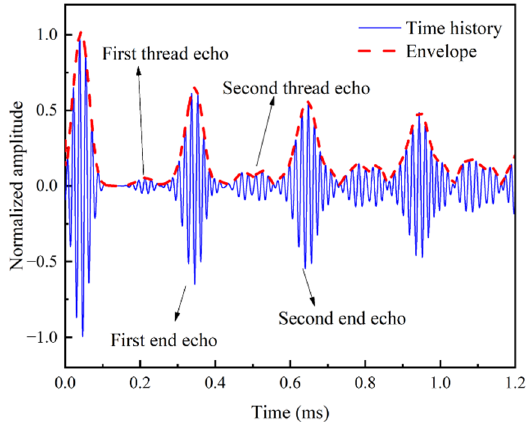
Figure 5. Excitation signal with central frequency of 60 kHz. ( a ) Excitation signal in time domain. ( b ) Excitation signal in frequency domain.